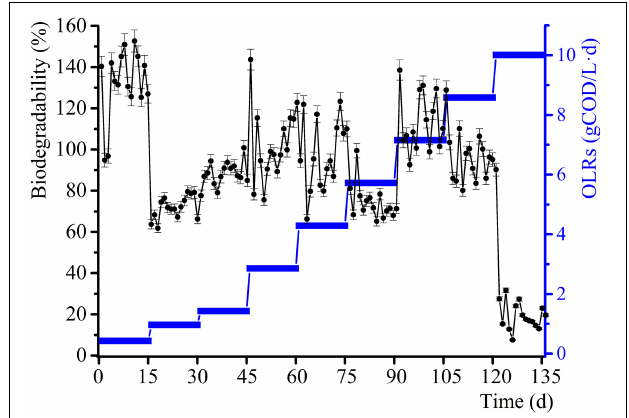
FIGURE 2 | Variation in biodegradability with increasing OLRs.